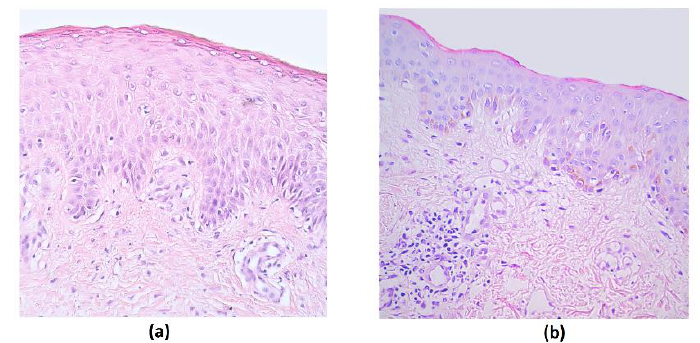
Figure 1. Routine stained micrographs of rosacea-affected facial skin tissues. ( a ) Note intraepithelial lymphocytes in a 44-year-old female. Hematoxylin and eosin, X 200; ( b ) inflammation in the subepithelial connective tissue in a 35-year-old female. Hematoxylin and eosin, X 200.